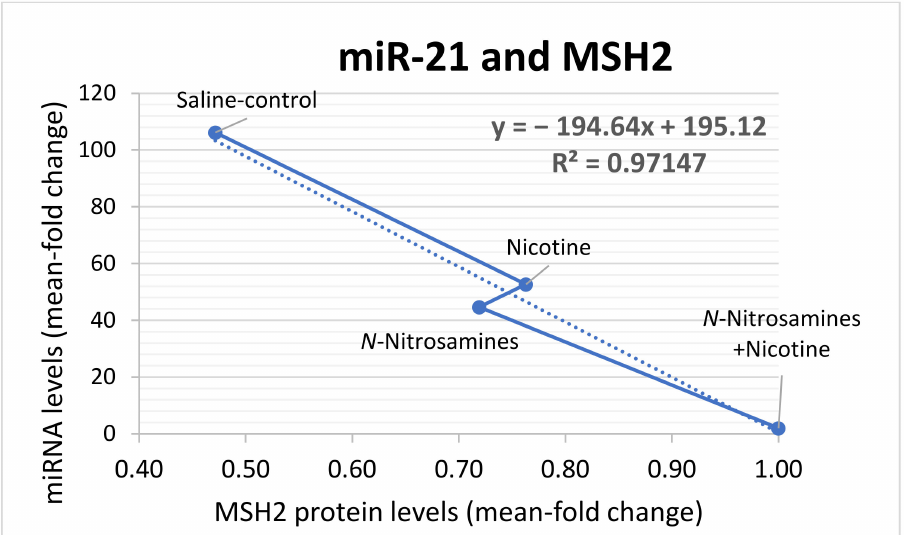
Figure 7. The impact of miR-21 deregulation on MSH2 protein output caused by TS components. Total MSH2 protein levels reduced by the upregulation of “oncomir” miR-21 expression in tobacco smoke components-exposed hypopharyngeal mucosa. ( r = − 9856, p = 0.0072; by Pearson analysis). (MSH2 protein levels: mean of total MSH2 immunostaining/total number of cells quantified by Image scope; miR-21 levels: mean of expression levels normalized to RNU6 by